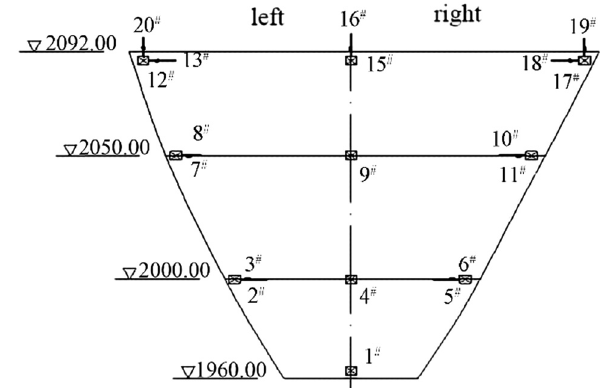
Figure 5: The layout of measuring points on the downstream surface of the dam.